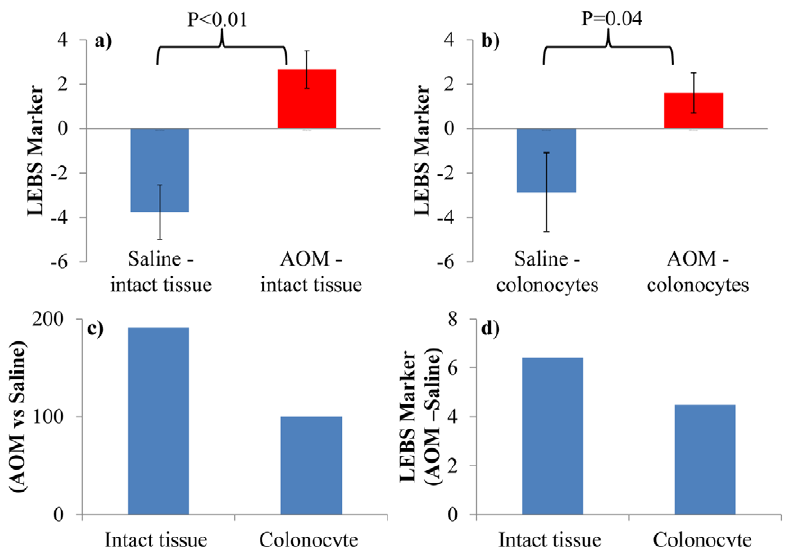
Fig. 2. Structural Changes from intact colon tissue are partially from colon cells. a,b) The LEBS marker is altered in the intact AOM-treated rat tissue and in isolated colonocytes as compared to saline-treated rats, demonstrating differences in micro- and nano-architecture that can be captured with the LEBS technique. The magnitude of the alteration in the LEBS marker is higher for intact tissue compared to colonocytes. c,d) The effect size (2.c.) and delta (2.d.) between AOM-treated and saline-treated rats are higher for intact tissue than for isolated colonocytes. Because colonocytes are part of the intact tissue, this result suggests that colonocytes are partially responsible for differences in LEBS marker from intact